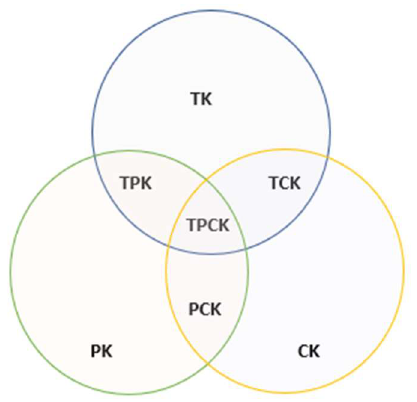
Figure 1. TPACK conceptual Model. Source: Taken from Koehler and Mishra, 2008 [9].